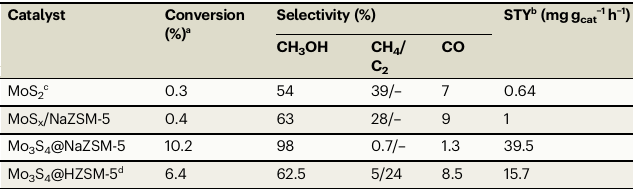
Table 2 | Catalytic hydrogenation of CO 2 over related